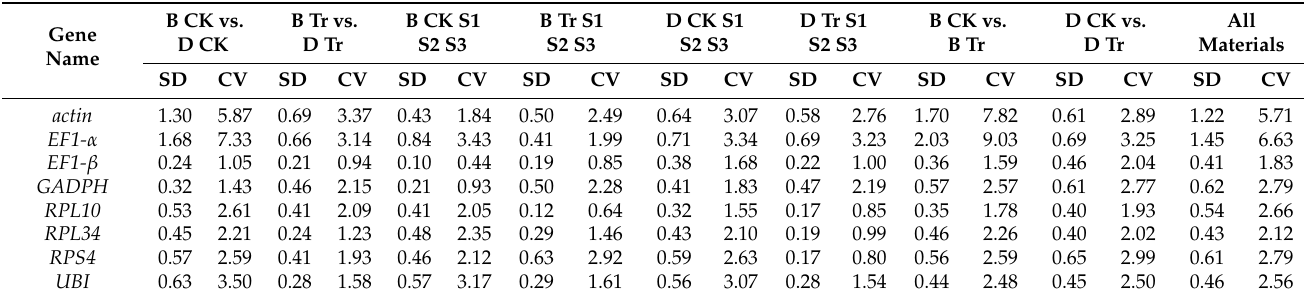
Table 5. Rank of candidate reference genes were calculated by Bestkeeper in each group.